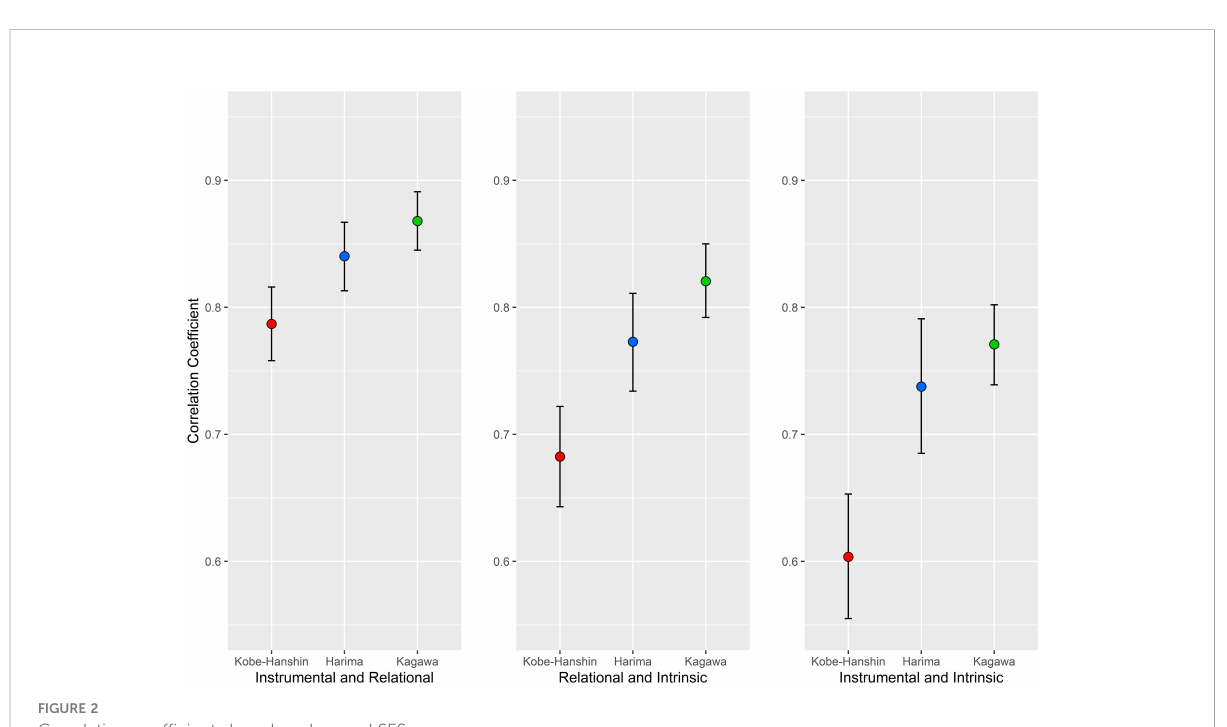
FIGURE 2 Correlation coef fi cients by value class and